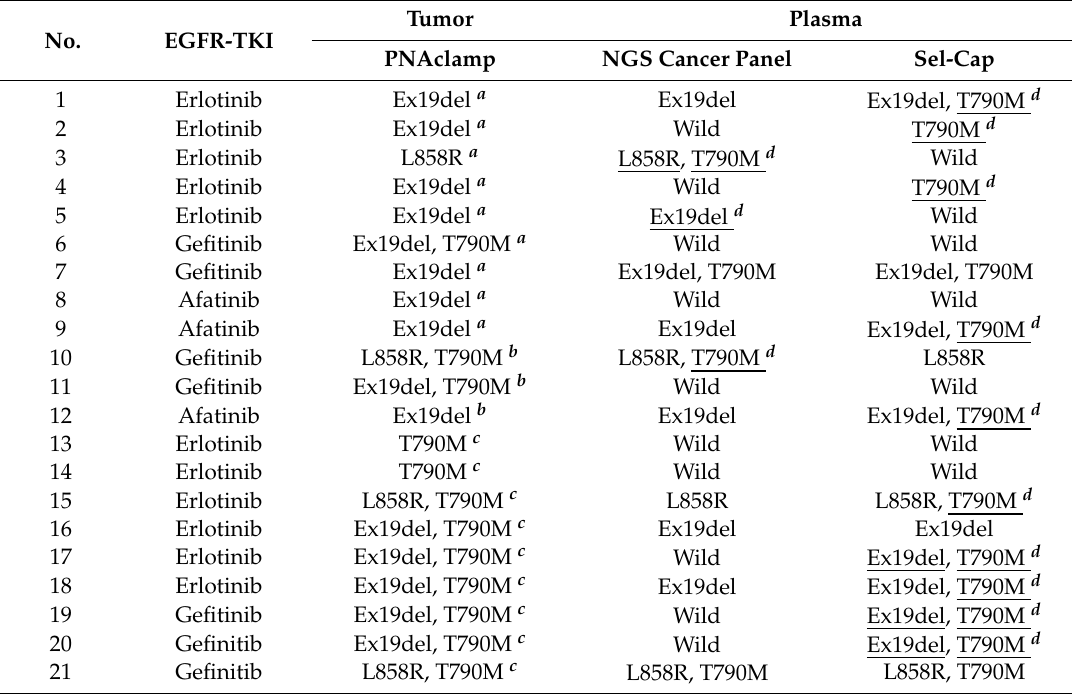
Table 3. Concordance between two NGS-based lipid biopsy platforms for EGFR mutations in NSCLC patients (n = 21), post development of resistance to first-line